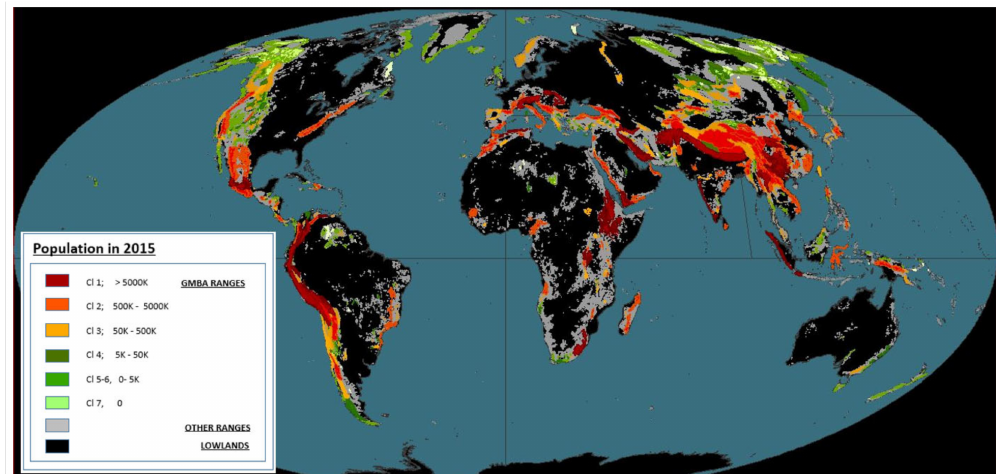
Figure 2. Overview of WCMC mountain extent with GMBA mountain ranges grouped in classes of population size. Ranges above 5 million (Cl_1), between 500 thousand and 5 million (Cl_2), between 50 thousand and 500 thousand (Cl_3), between 5 thousand and 50 thousand (Cl_4), between 5 hundred and 5 thousand (Cl_5), below 500 (Cl_6), and not populated ranges